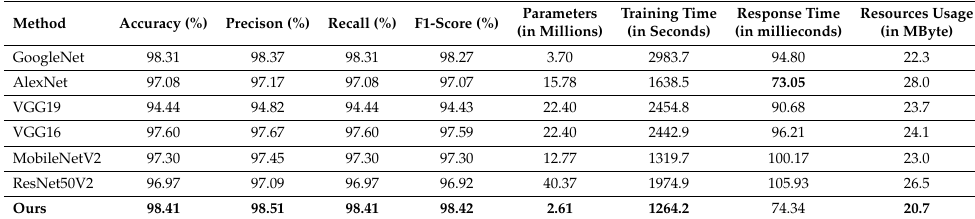
Table 3. Comparative analysis of detection performance on